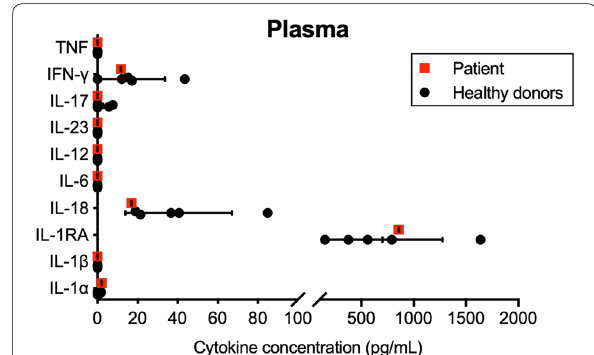
Fig. 1 Similar levels of cytokines in the plasma of the patient and healthy donors. Concentrations of IL‑1α, IL‑1β, IL‑1RA, IL‑18, IL‑6, IL‑12, IL‑23, IL‑17, IFN‑γ and TNF were determined by multiplex assays in the plasma of healthy donors (black dots) and the patient with aggressive RA‑like PsoA (red square). Results are expressed as mean standard ± deviation for the healthy donors (n 5) =